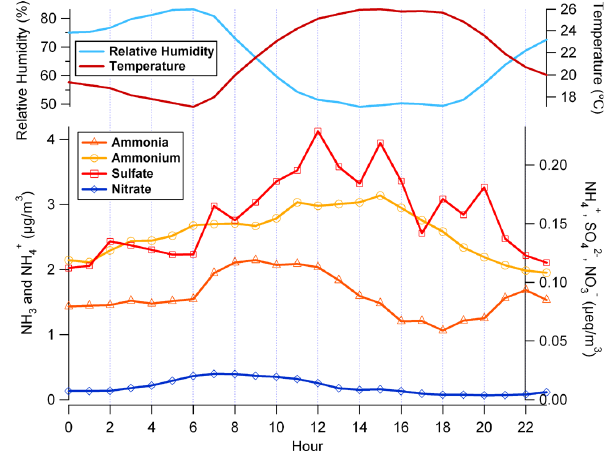
Fig. 4. Average diurnal cycles of relative humidity and temperature with ammonia and ammonium concentrations. Ammonia concen- trations display a rise in the early morning hours, followed by de- crease in the afternoon. Mole equivalents of ammonium, sulfate and nitrate are plotted on the right axis and show the relative importance of sulfate and nitrate in the